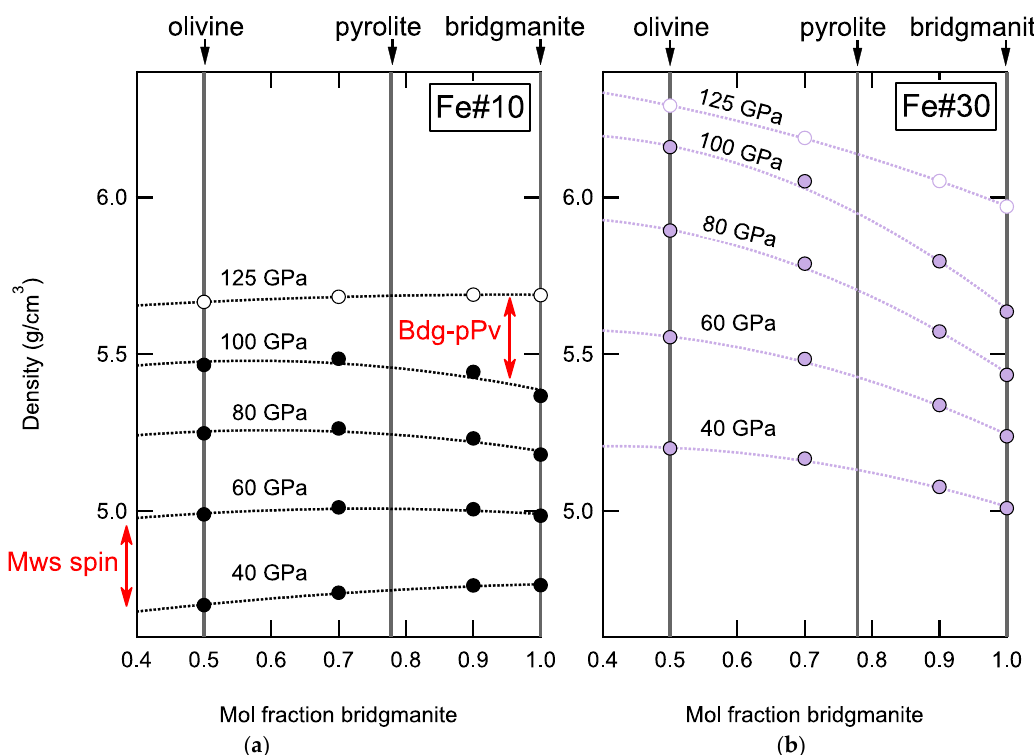
Figure 6. Density of a lower mantle phase assemblage comprising ferrous-iron-bearing bridgmanite, ferropericlase, and post-perovskite as a function of mol% silicate and pressure. The % bridgmanite marked “pyrolite” corresponds to the pyrolite Mg/Si ratio, but does not address other elemental abundances in pyrolite (e.g., Al and Ca). Densities are calculated based on partitioning data in this study and equation of state data for bridgmanite, ferropericlase, and post-perovskite as detailed in Supporting Text. Filled symbols = bridgmanite and ferropericlase phase assemblage, open symbols = post- perovskite and ferropericlase. Compositions are modeled at pressures 40, 60, 80, 100, and 125 GPa (dotted lines = isobars) for fixed bulk Fe# ( a ) Fe#10, representing average mantle, and ( b ) Fe#30, representing dense mantle heterogeneity. Heterogeneous mantle SiO 2 -content may also explain enigmatic differences in seis- mic velocities V S and V P in LLSVPs [56]. The deep lower mantle has been noted for anti- correlation of V S and V P , which neither thermal differences nor iron content alone can ex- plain [4]. However, differences in Fe-content in combination with SiO 2 -content produce complex effects on density and compressibility. Further studies on composition, pressure, and temperature dependence of thermoelastic properties will test whether dense hetero- geneities such as LLSVPs are enriched or depleted in SiO 2 .